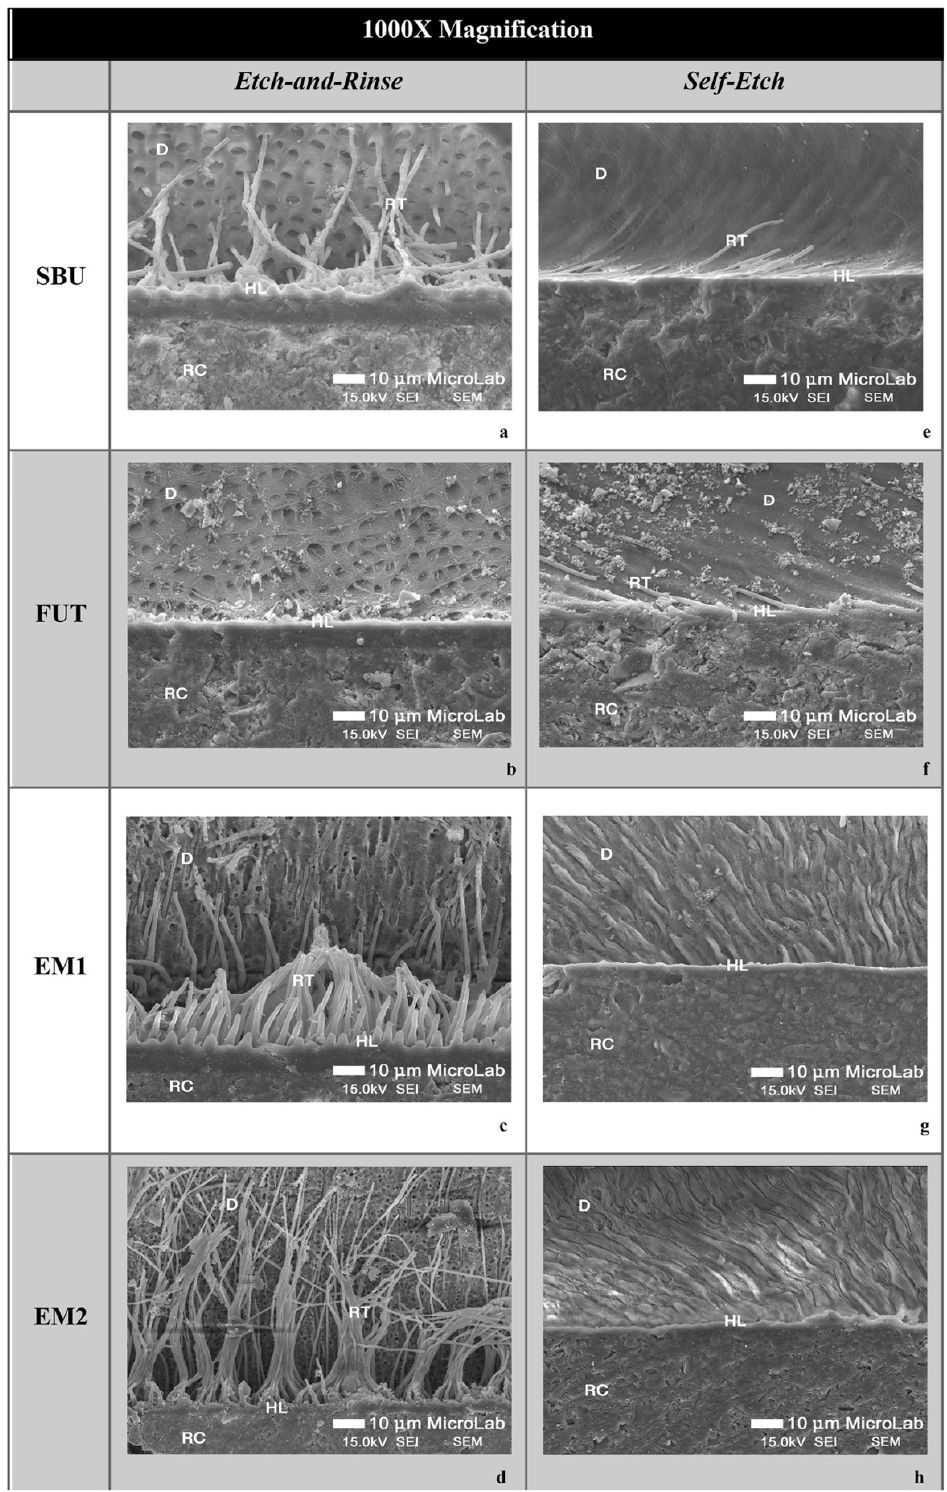
Figure 2. FEG-SEM micrographs of the adhesive interface at 1000 × magnification. ( a – d ) adhesives using an ER strategy; ( e – h ) SE strategy. Resin tags are represented as (RT), resin composite (RC), dentin (D) and hybrid layer (HL). In a higher magnification it is possible to observe, again, long, dense and thick resin tags with EM1 and EM2, although EM2 seems to show better tubule penetration in opposition to EM1.